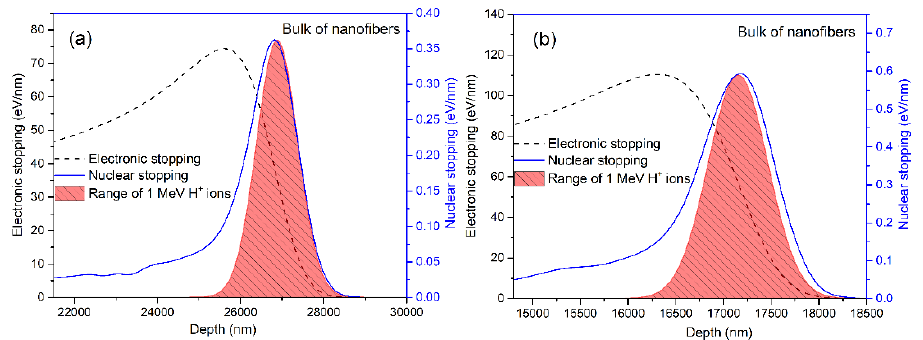
Fig. 1. The SRIM calculation of the electronic and nuclear energy stopping of 1 MeV H + ions vs. depth and the 1 MeV H + ion depth profiles in PA6 (a) and PVDF